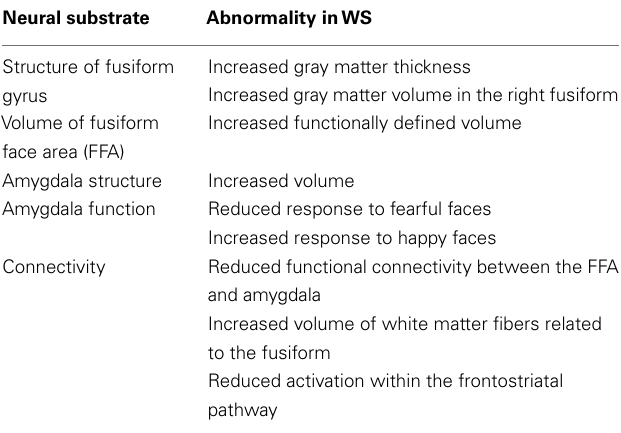
Table 2 | Summary of neural substrates of social-emotional functioning